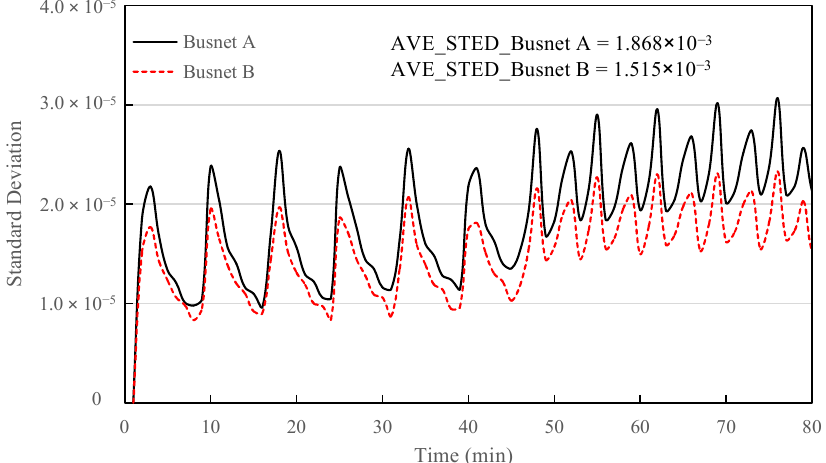
Figure 12. Standard deviation of alumina concentration in the underfeeding and overfeeding cycles (Case 0 vs. Case 2).